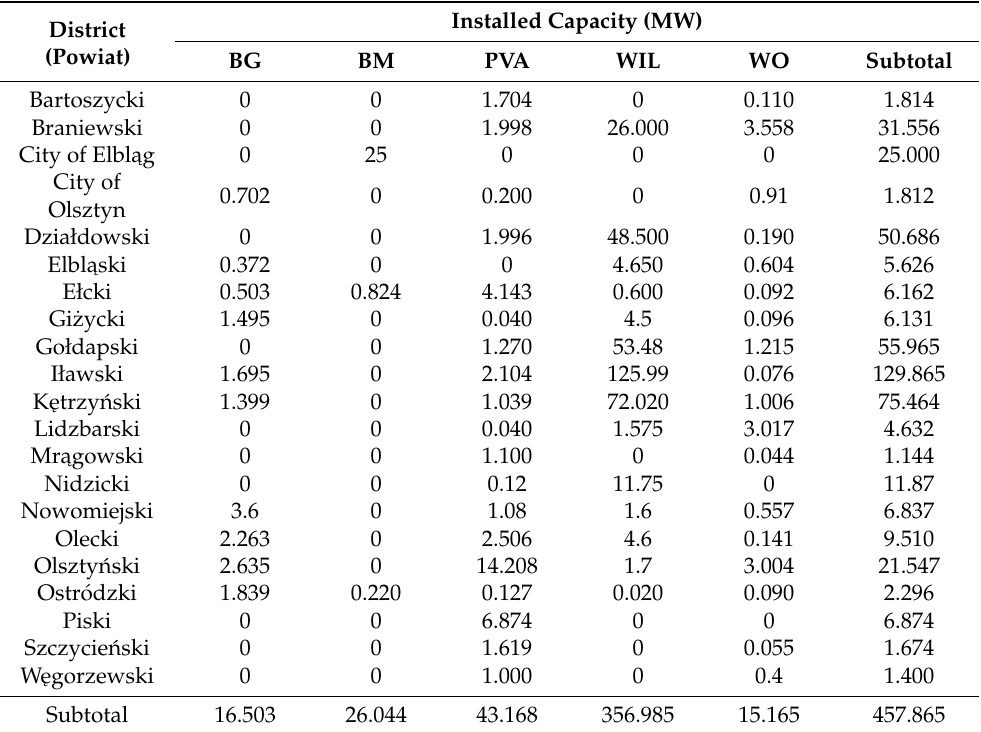
Table 9. Renewable energy installations in the Warmia and Mazury Province as of 31 December 2019 (letter code in accordance with Table